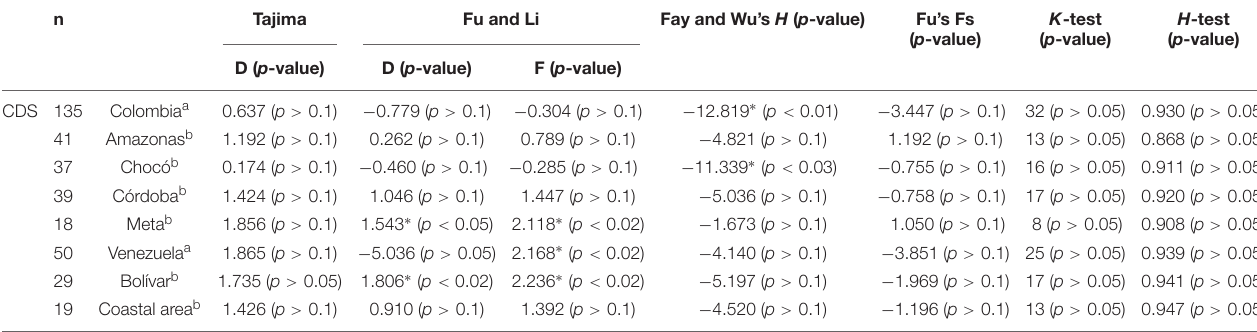
TABLE 2 | Neutrality tests for Colombia, Venezuela, and subpopulations.